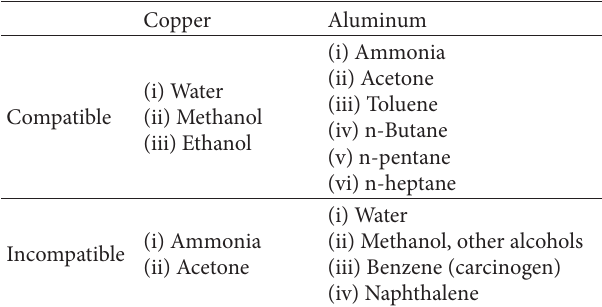
Table 7: Fluids compatible with copper and aluminum, based on heat pipe life